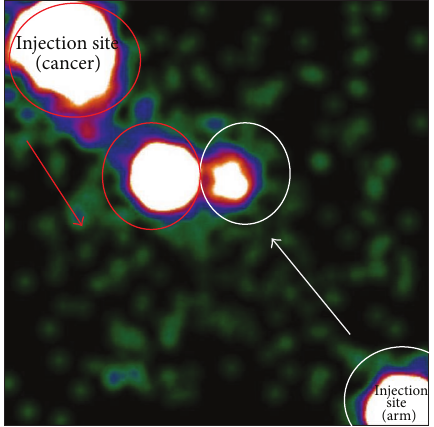
Figure 2: Intraoperative lymphoscintigraphy ( 99 m TC-labelled human albumin microcolloid, subdermally injection) of patient with palpable left breast cancer (red circles) 1h after previous axillary reverse mapping through a lower dose of radiotracer injected subcutaneously in the intramuscular groove of inner ipsilateral arm (white circles). Anterior view shows the progressive acquisition of two different patterns of lymphatic drainage carried out in separate